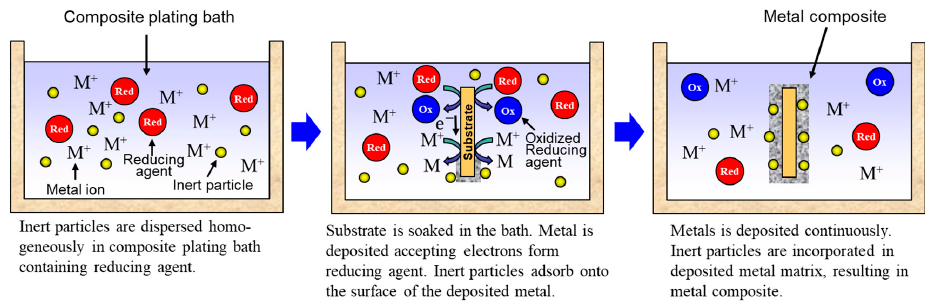
Figure 4. Schematic of composite plating by electroless deposition.